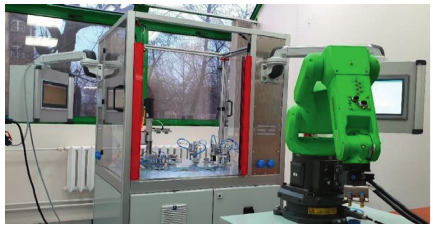
Figure 2: General view of the entire station.